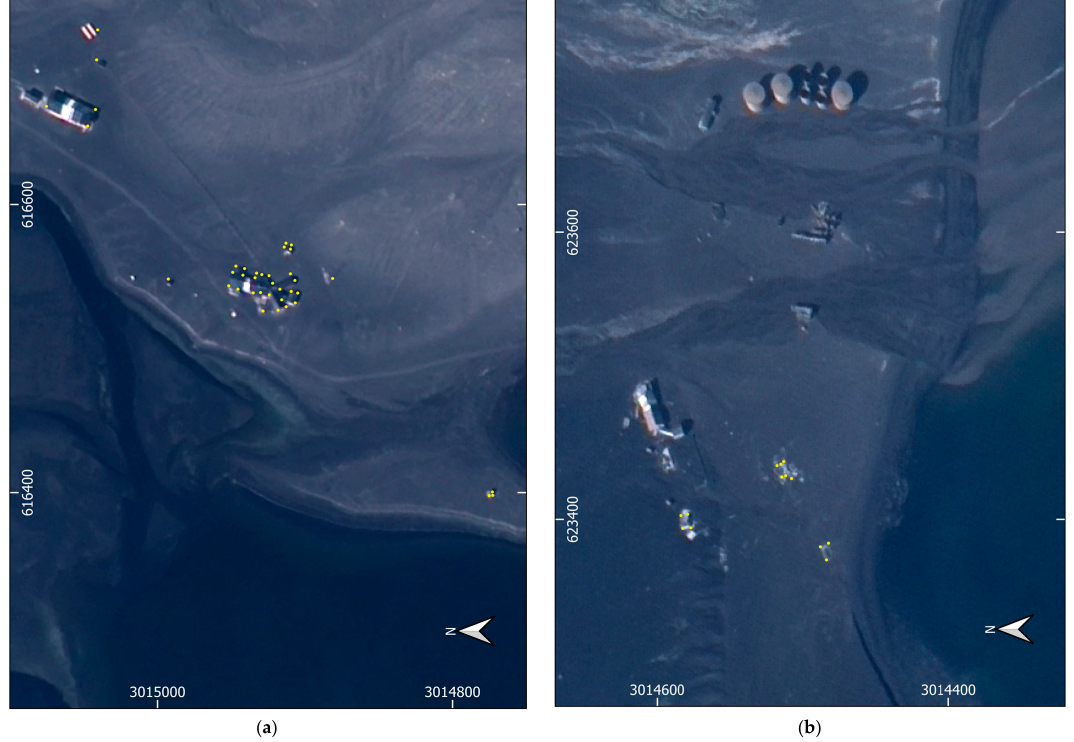
Figure 5. Argentinean ( a ) and British ( b ) bases in 2020. Ground control points are coloured yellow, coinciding with the corresponding features, in WGS84–UTM20S. Includes material ©KARI 2020, copyrighted distribution (SI Imaging Services, Republic of Korea), all rights